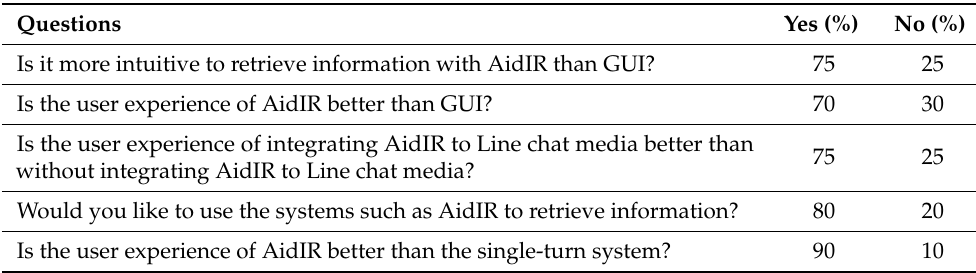
Table 12. Results of yes–no questions.